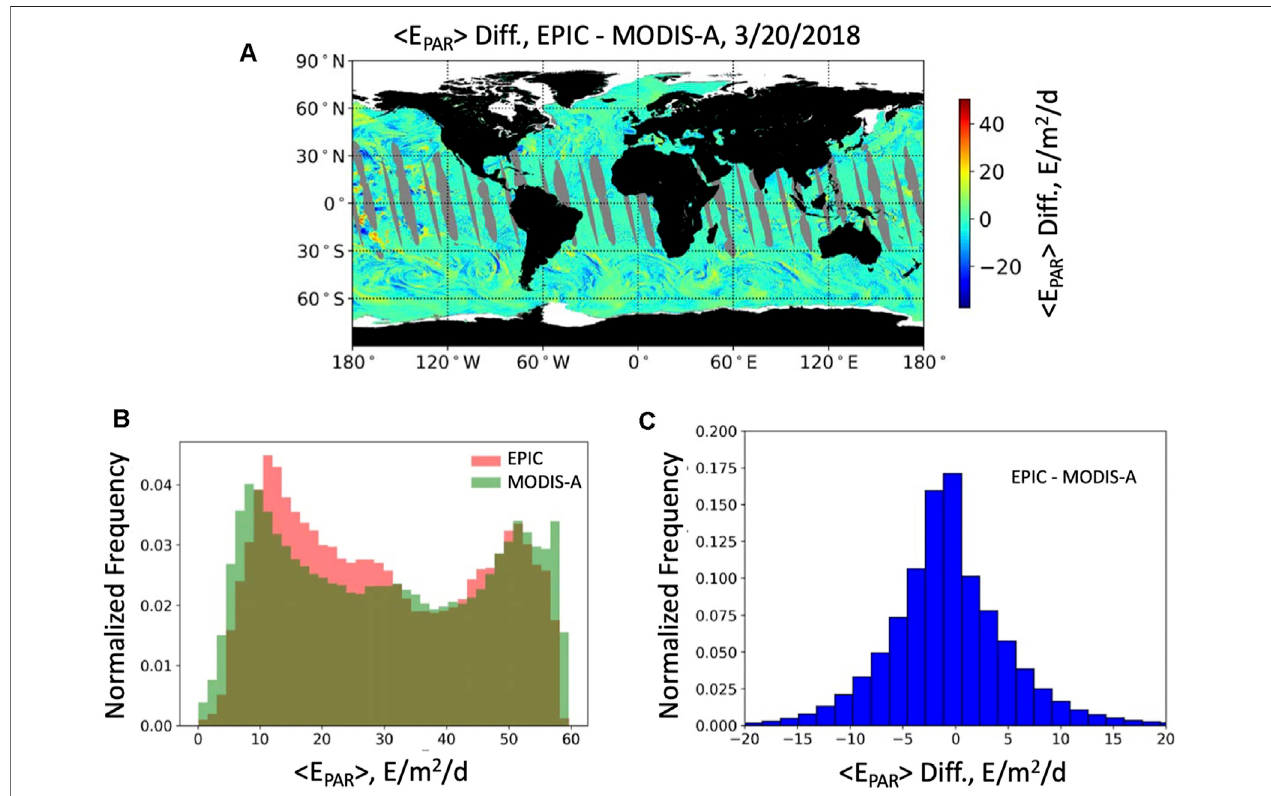
FIGURE9|(A) MapofthedifferencebetweenEPICandMODIS-A < E PAR > estimatesforMarch, 20,2018; (B) histogramoftheEPICandMODIS-A < E PAR > values; (C) histogram of the EPIC difference between EPIC and MODIS-A < E PAR > estimates.